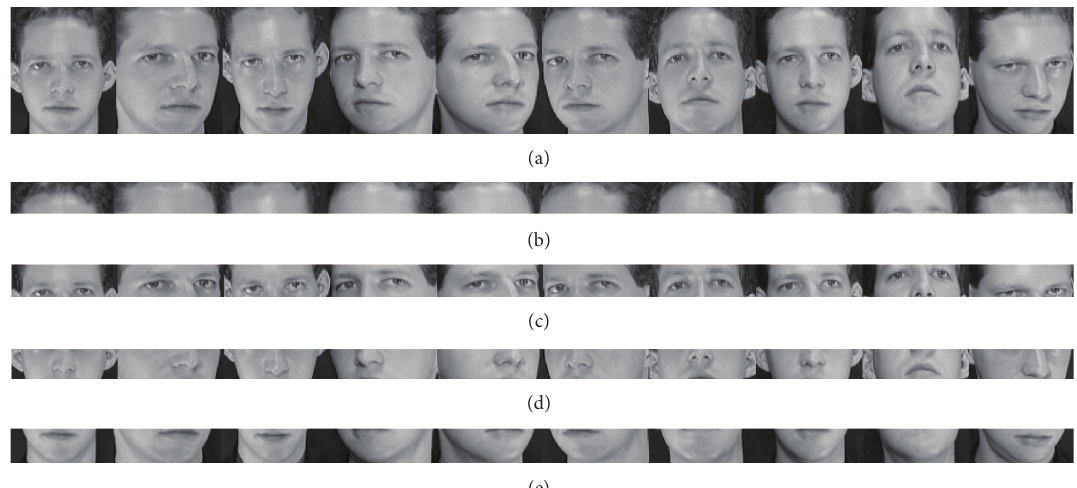
Figure 1: Images and their blocks of the first subject from ORL database: (a) 10 images of size 112 × 92; (b)–(e) 4 image blocks of size 28 × 92 for each image in